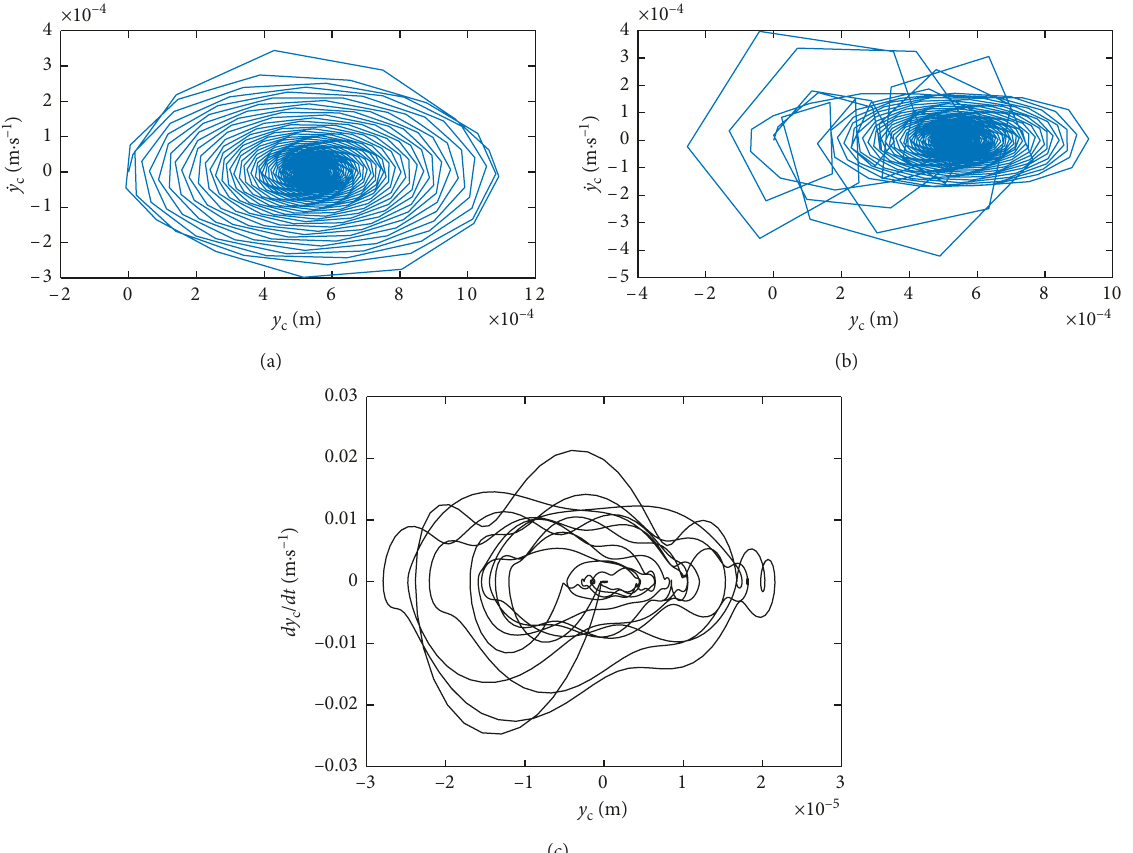
Figure 7: Phase diagrams: (a) simulation results for brake model without contact loss; (b) simulation results for brake model with contact loss; (c) phase diagram evaluated from measured vibration data in stage C in Figure